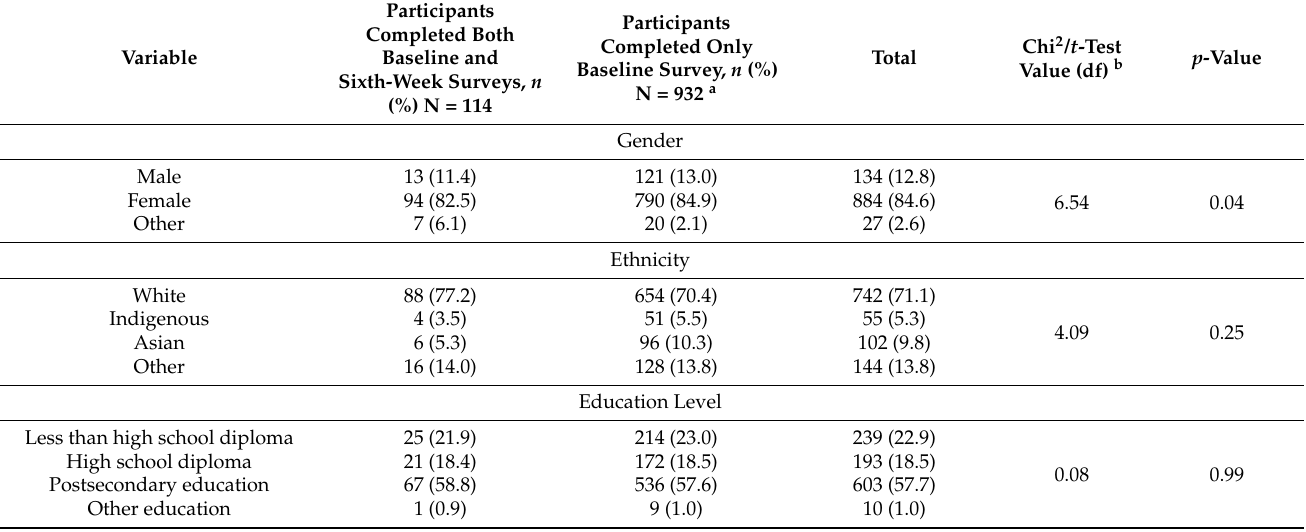
Table 1. Distribution of the demographic and clinical characteristics between the participants who completed both the baseline and sixth-week survey and the participants who completed only the baseline